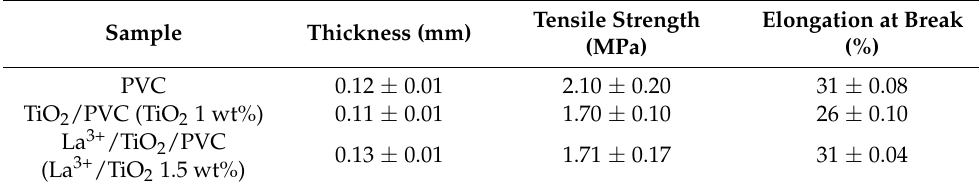
Table 2. Mechanical properties of these kinds of different films.